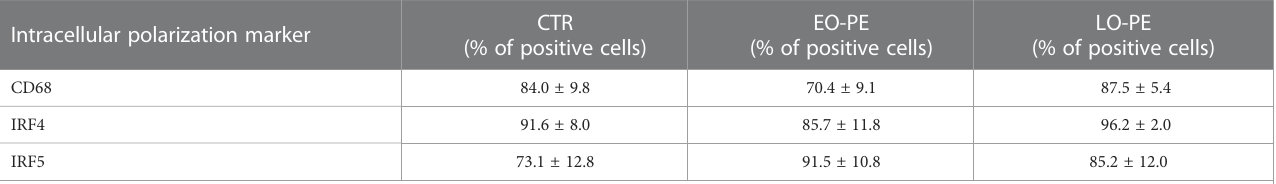
TABLE 3 Percentage of positive CTR (n=12), EO-PE (n=5) and LO-PE (n=4) HBCs for respective intracellular polarization markers. Intracellular polarization marker